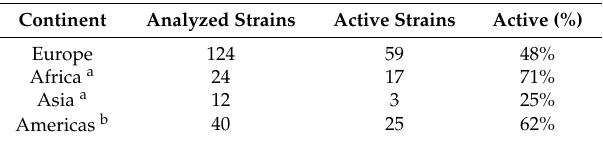
Table 1. Geographic origin of the analyzed